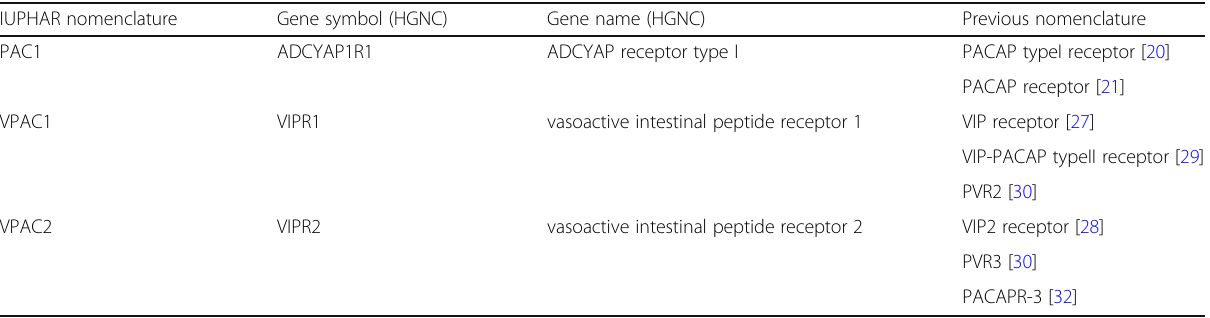
Table 2 Nomenclature of PACAP and VIP receptors by IUPHAR IUPHAR nomenclature